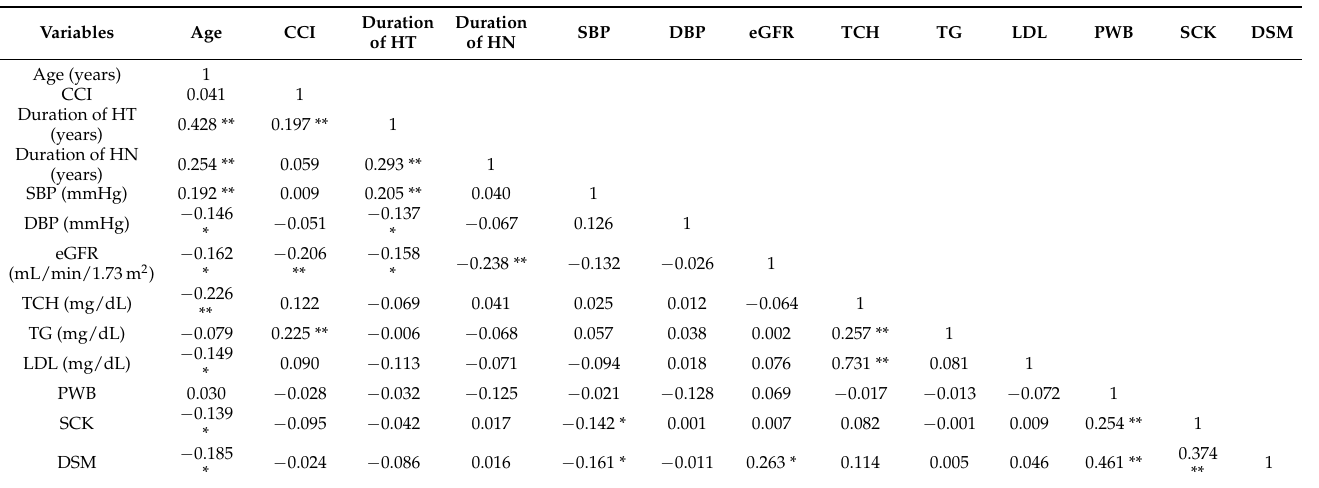
Table 2. Analysis of the correlation among demographic data, physiological index, self-care knowl- edge, psychological well-being, and disease self-management in patients with hypertensive nephropa- thy ( n = 220).